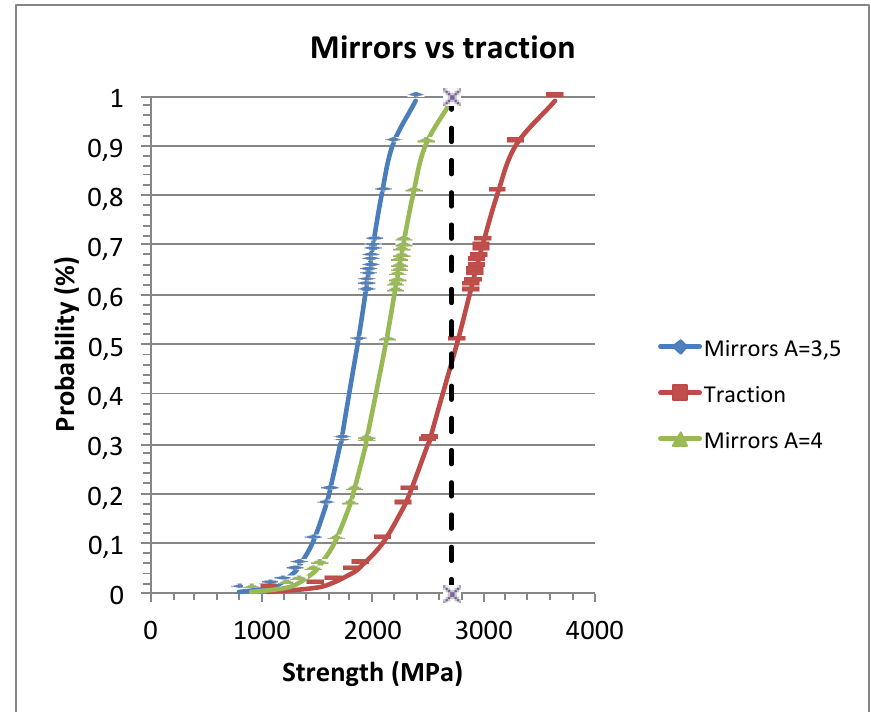
Figure 15. Comparison of flaw strengths derived from fracture mirror sizes and the cumulative distribution of filament strengths measured in tension. Probability for flaw strengths was estimated using the estimator (i − 0.5 )/n , and i is the rank of the strength data in ascending order, n ( n = 21) is the number of data.